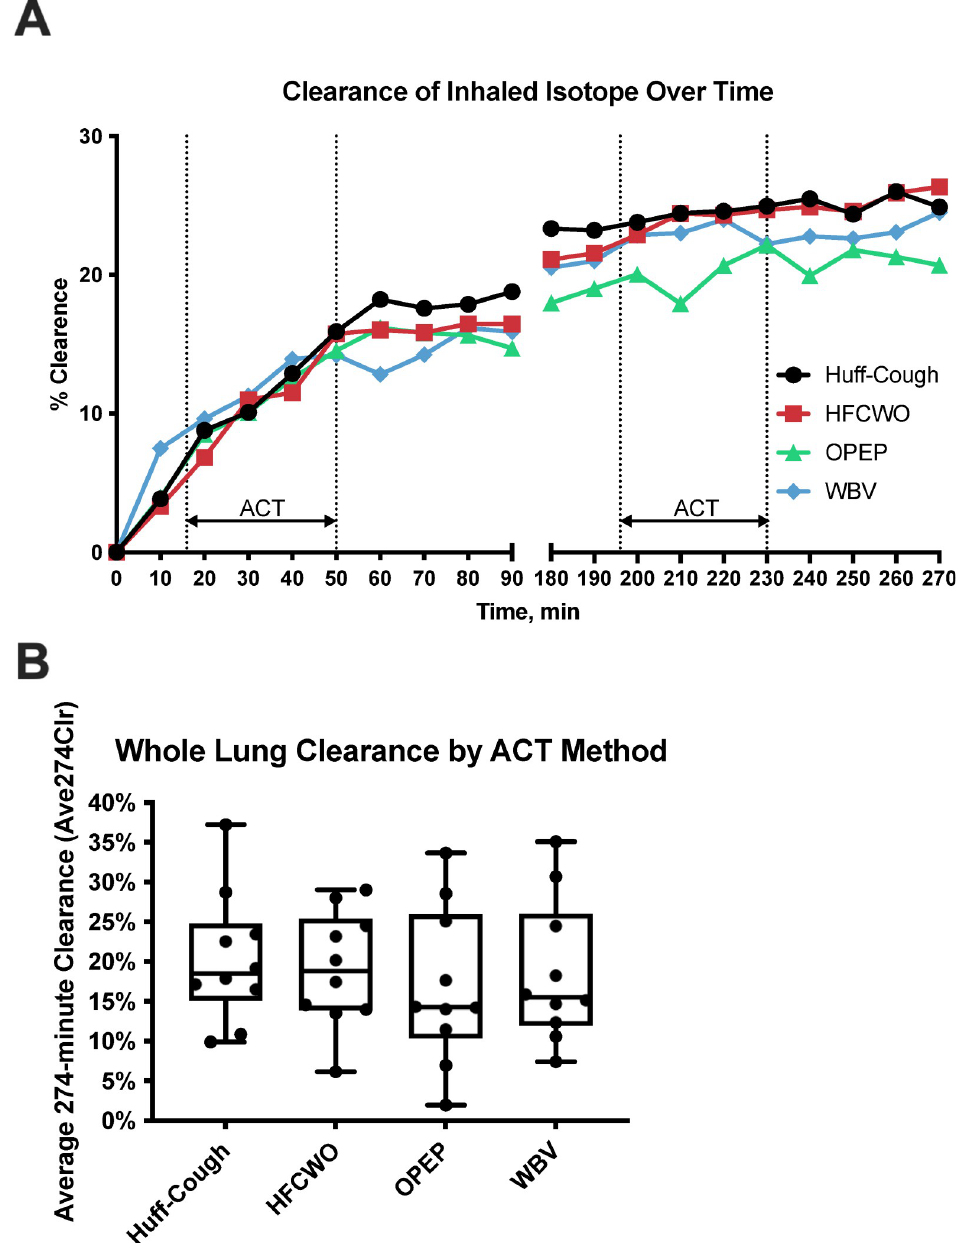
Fig 2. Clearance of inhaled isotope as measured via gamma scintigraphy. (A) Average clearance of inhaled isotope over time through 274 minutes. (B) Box plot of average whole lung clearance through 274 minutes. No differences were observed between ACT